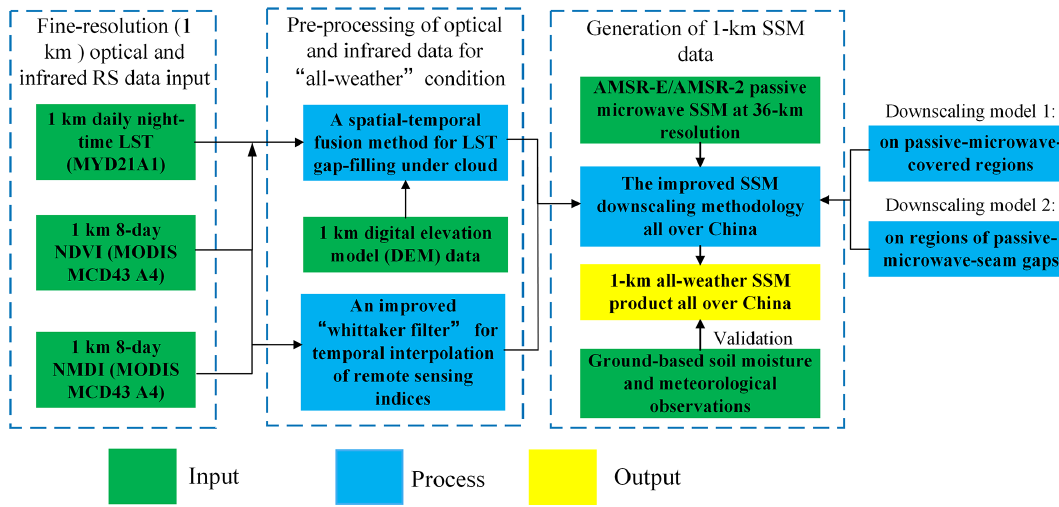
Figure 2. The overall methodological framework of this